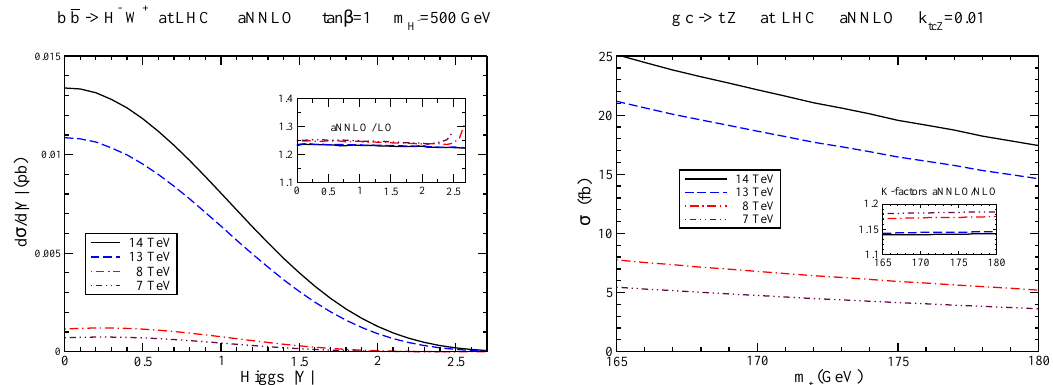
Figure 2. ( Left ) the aNNLO rapidity distribution of the charged Higgs boson in H − W + production at LHC energies; ( Right ) the aNNLO total cross section for the process gc → tZ